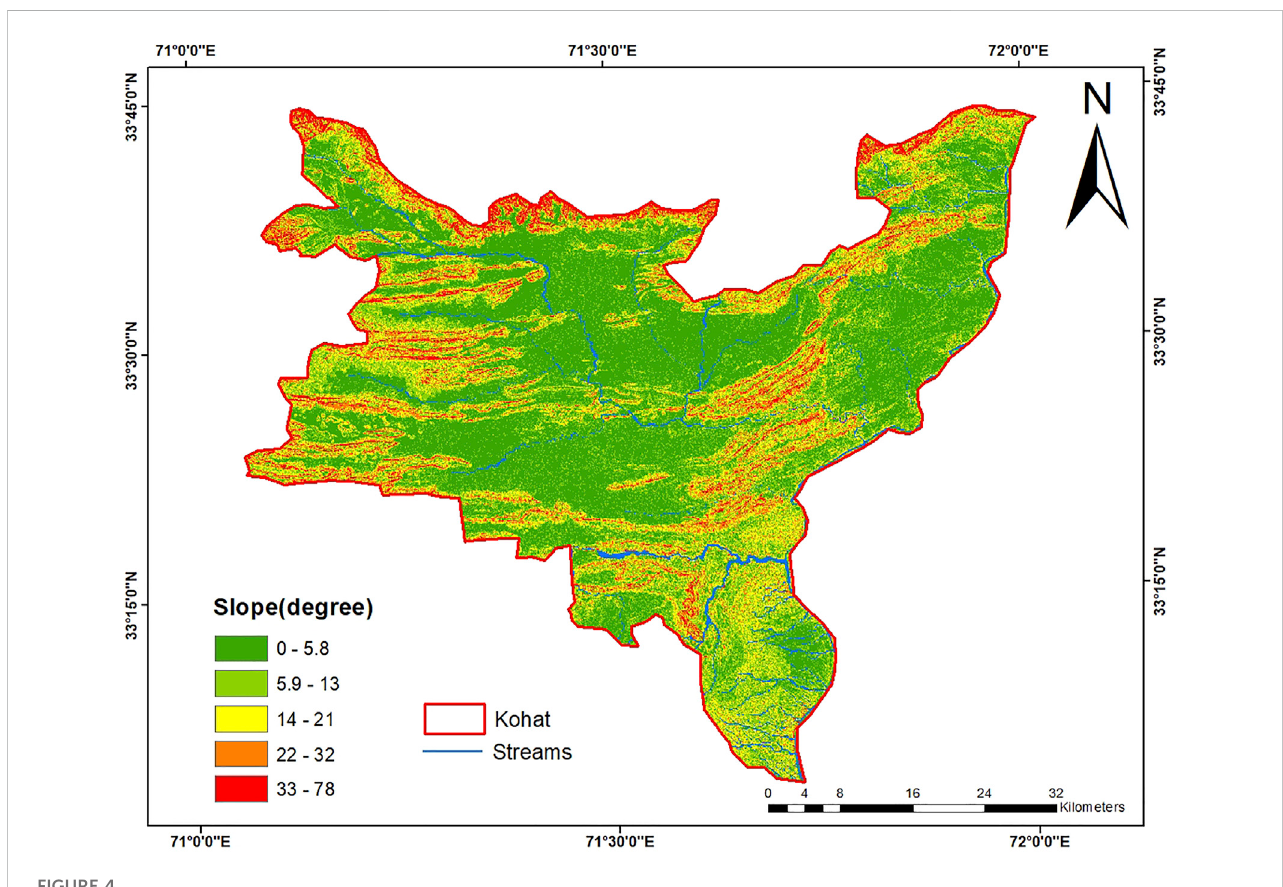
FIGURE 4 Slope map of the study